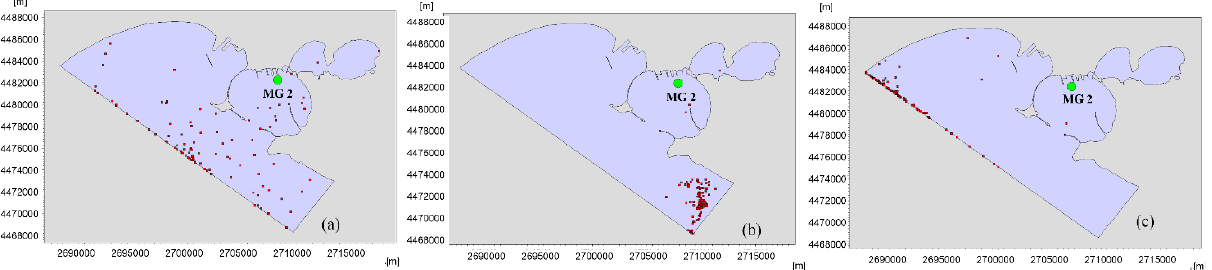
Figure 11. Percentage PT1 (MG1) — the cloud of particles: ( a ) 30 days after release; ( b ) 60 days after release; ( c ) 90 days after release at bottom layer.